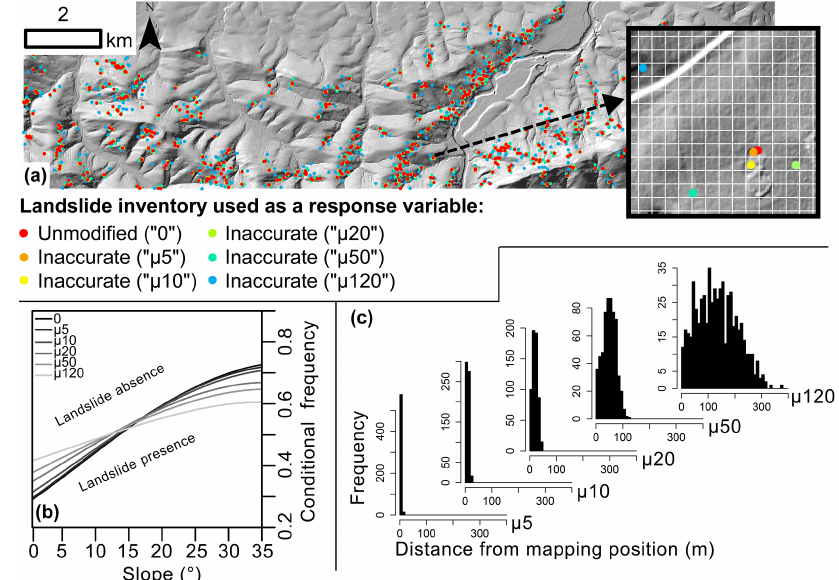
Figure 2. Overview of the simulated positional inaccuracy of the inventory for the study area (real data). The excerpt in (a) shows an example of an original mapping position of a landslide scarp (red dot) and corresponding simulated positional inaccuracies (the white grid corresponds to the modelling resolution of 10m). The conditional frequency plot in (b) shows that a decreasing positional accuracy of the inventory led to the effect that landslides were more likely located on flatter slopes. The histograms in (c) (bin width 10m) depict the frequency of landslides ( n = 591) in relation to the distance from the original mapping position for the respective simulated positional inaccuracy.